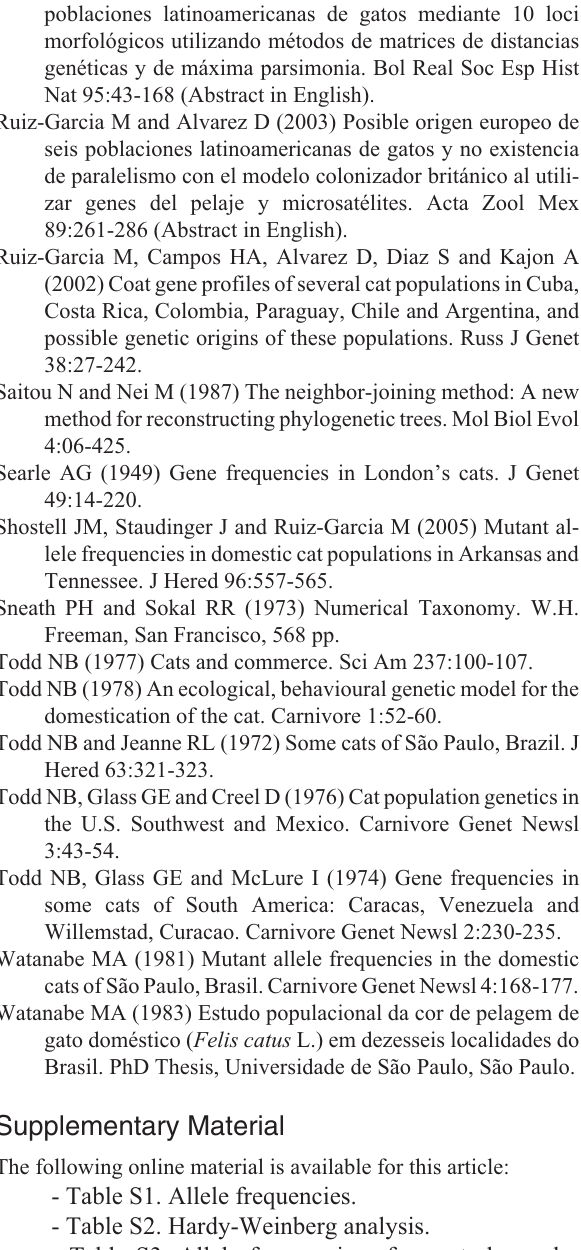
- Table S2. Hardy-Weinberg analysis. - Table S3. Allele frequencies of ancestral popula- tions. - Table S4. Temporal allele frequency